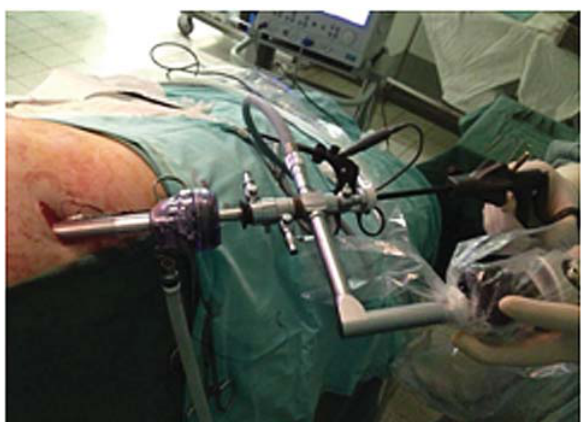
Figure 1 - Positioning of trocar and use of nephroscope for retroperitoneoscopy.